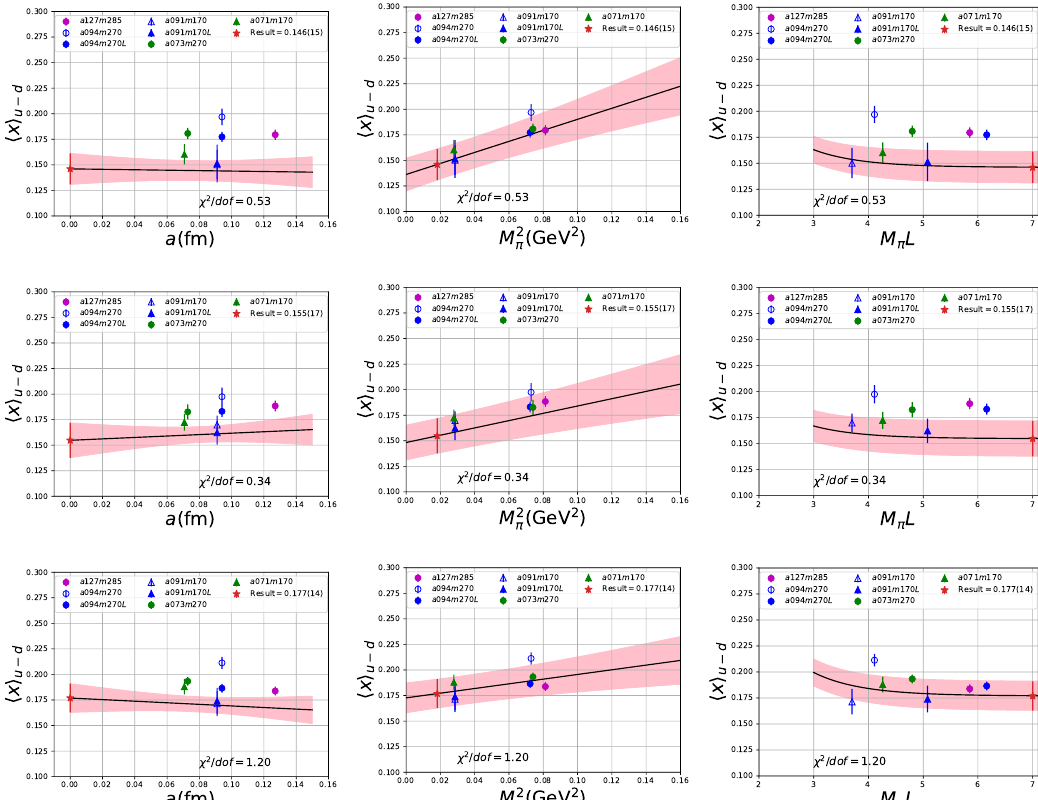
Figure 1 . Data for the momentum fraction h x i u − d from the seven ensembles renormalized using method A in the MS scheme at µ = 2 GeV. The top row shows data obtained using the { 4 Nπ , 3 ∗ } fits strategy, middle from { 4 , 3 ∗ } and bottom from { 4 , 2 free } . The pink band shows the result of the CCFV fit plotted versus a (left panel), versus M 2 (middle panel) and versus M (right panel) with π L π the other two variables set to their physical values in each case. The desired value at the physical point is shown by the symbol red star. Note that, since we do not shift the data to account for the corrections due to the other two variables in each panel, the data and the result of the simultaneous fit (pink band with central value given by the black line) are not expected to coincide. By presenting unshifted data, we allow the reader to see the size of the corrections due to extrapolation in the other two variables, ie, roughly the difference between the data point and the central value given by the fit. The χ 2 /dof show that the fits are